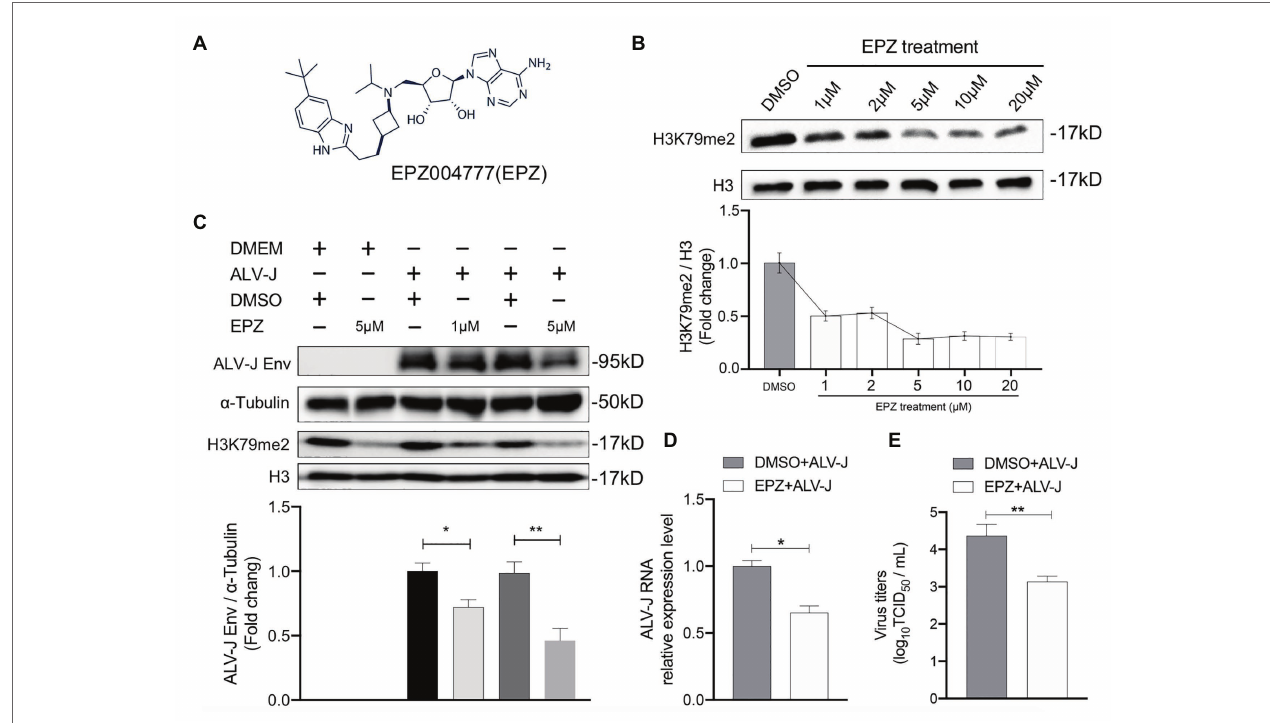
FIGURE 2 | Chemical blockade of DOT1L promotes ALV-J clearance in HD11 cells. (A) Chemical structure of DOT1L inhibitor EPZ004777 (EPZ). (B) The blocking efficiency of EPZ was evaluated by western blotting. HD11 cells were incubated with various concentrations of EPZ or the vehicle control DMSO for 48 h, and the levels of H3K79me2 was determined by western blot (upper panel). Total histone H3 were used as internal control. Relative protein levels were quantified with ImageJ software and normalized to the amount of total H3 (lower panel). (C) Western blot analysis of ALV-J Env protein. HD11 cells were infected with ALV-J (MOI 2) in the presence of indicated concentrations of EPZ or vehicle control. ALV-J Env protein and the levels of H3K79me2 was determined at 48 hpi. β -actin and histone H3 were used as internal control (upper panel). Relative protein levels of ALV-J Env were quantified with ImageJ software and normalized to the amount of β -Actin (lower panel). HD11 cells were incubated with 5 μM of EPZ004777 for 24 h and then infected with ALV-J (MOI 2) for 48 h. Viral RNA levels were measured by qRT-PCR. GAPDH mRNA level was measured as an internal control (D) .Viral RNA was Viral yield in the supernatants was analyzed by (TCID 50 ) assay at 48 h after infection (E) . All the data were shown as mean ± SD (error bars) from three independent experiments. * p < 0.05; ** p < 0.01; unpaired, two-tailed Student’s t